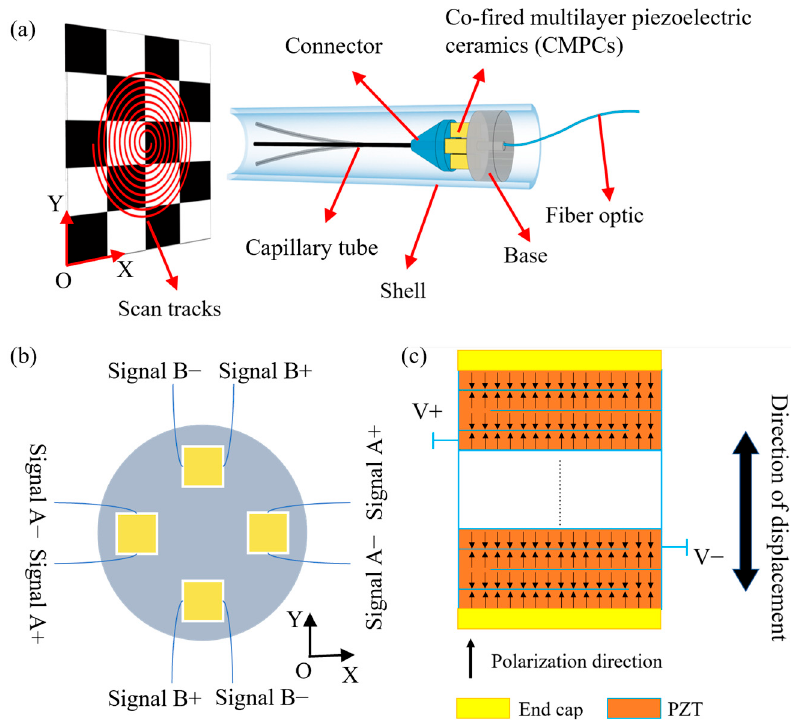
Figure 1. Schematic design of the scanner. ( a ) Structure diagram of the scanner. ( b ) Distribution of the four CMPCs (yellow parts) and voltage excitation strategy for them. ( c ) Structure diagram of the CMPC.